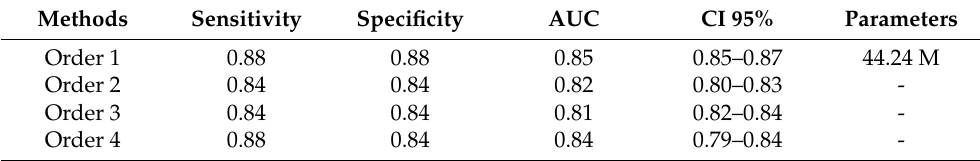
Table 2. Comparison experiments with different sequence orders.